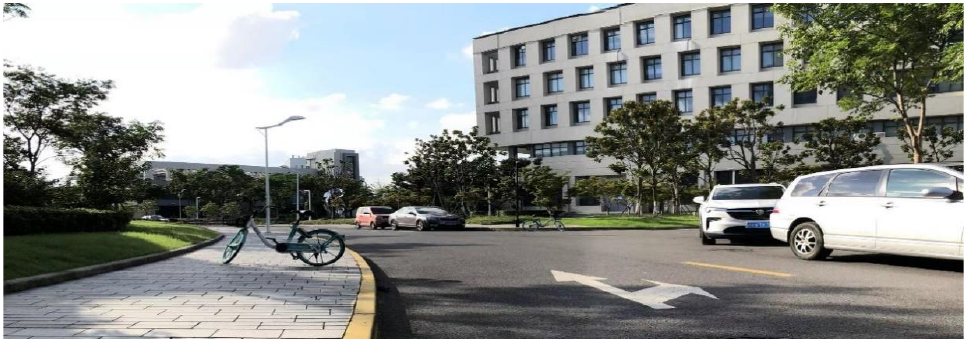
Figure 25. The view of the outdoor test scene.